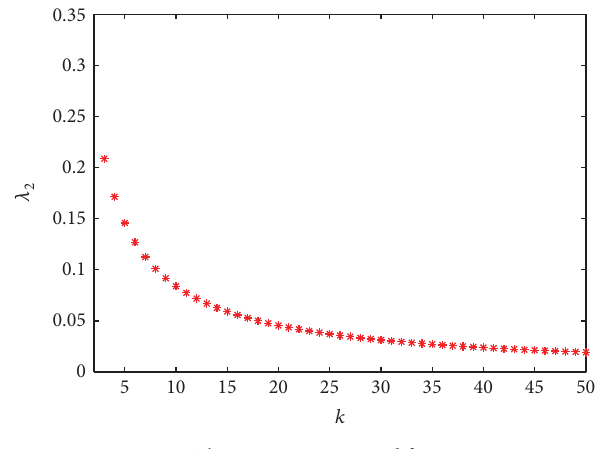
Figure 13: The convergence speed for 𝑆 𝑛−1 ∘ 𝑃 𝑘 .